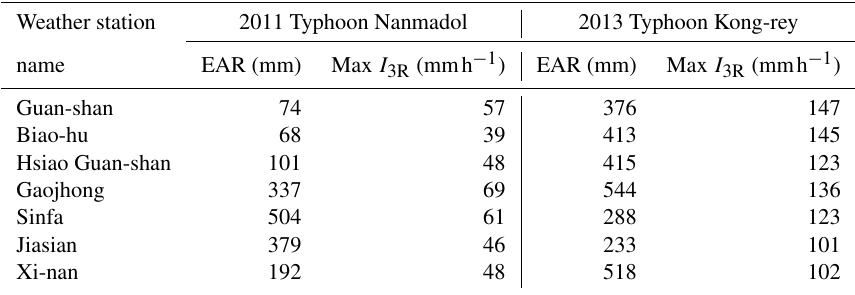
Table 4. Effective accumulated rainfall and intensity of rolling rainfall observed at weather stations during Typhoon Nanmadol and Typhoon Kong-rey.